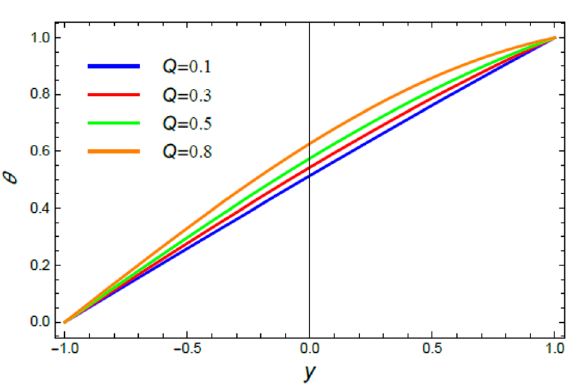
Figure 8. The effect of the heat resource coefficient Q on the heat distribution θ